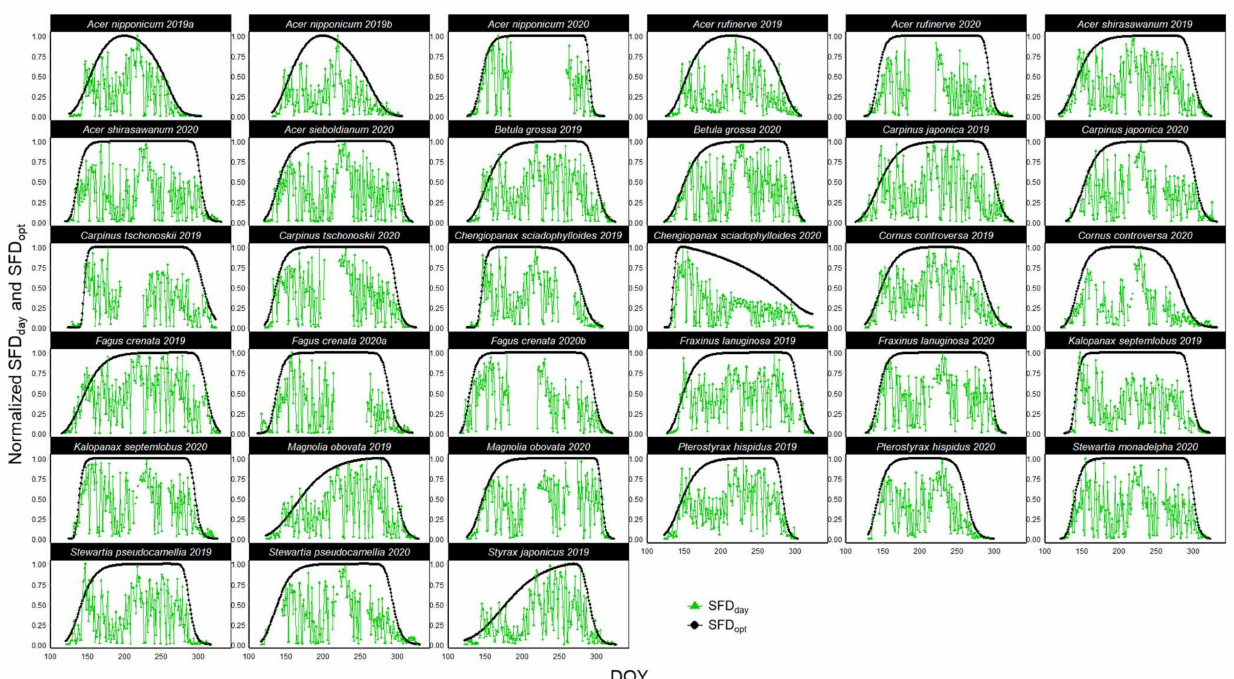
Figure A3. Seasonal trajectories of daytime total sap flux density (SFD day ) and the optimized SFD (SFD opt ) derived from Equations (6) and (7) for all individuals. All values are normalized to the scale from 0 and 1. Abbreviation: DOY, day of the year.